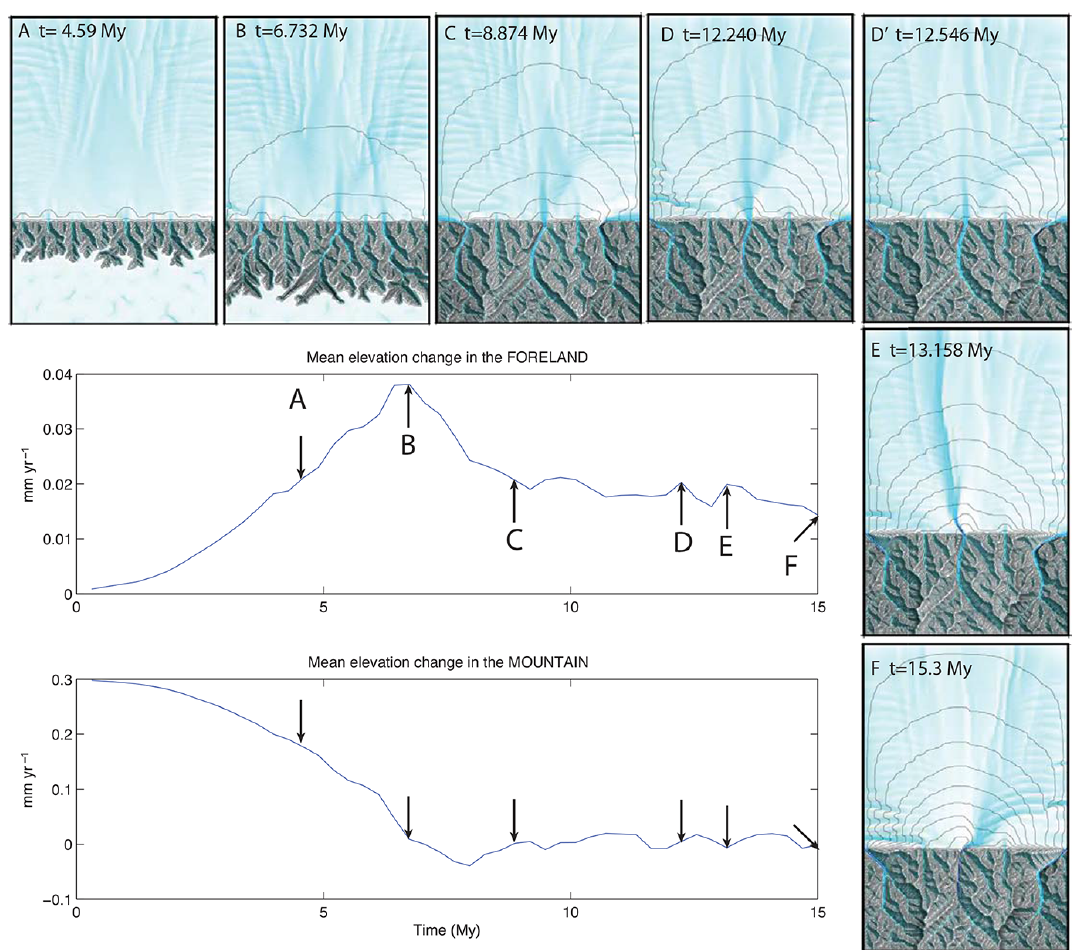
Figure 3. Building the megafan. Temporal evolution of the mean elevation change in the foreland and mountain and map views of the mountain and foreland landscapes (black lines are 100m contour lines, water flux in blue shades) at the time steps marked with arrows, through the megafan building phase. (A) Drainage network initiates and propagates in the mountain block through headward incision, while sediments are deposited along the front by regularly spaced streams. (B) Deposits merge in the foreland to form a bajada fed by a decreasing number of rivers as the mountain streams enlarge their basins. (C) Mean elevation in the range stabilizes and aggradation continues in the foreland, dominated by outflux of a central, main channel as the more lateral streams are drained directly toward the borders. (D) As aggradation continues, limited incision can occur along the borders of the fan (here on the western border) but (D’) those streams are quickly refilled. (E) Similarly, temporary incision can happen near the apex. (F) After 15.3Myr the megafan is